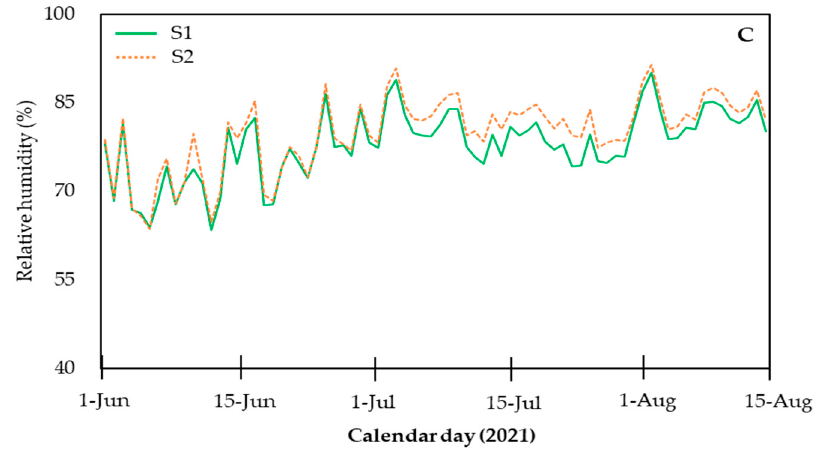
Figure 1. The average solar irradiance (11 a.m. to 3 p.m.) ( A ), average daily temperature ( B ) and relative humidity (%) ( C ) in both S1 and S2 sections of the greenhouse during the treatment period. S1 and S2 indicate single shade screen and double shade screens respectively.